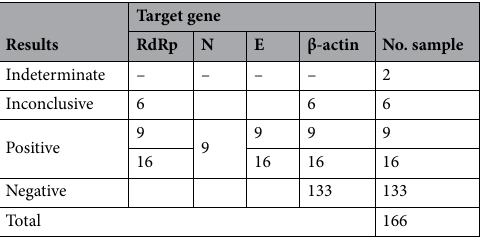
Table 6. Results obtained by our assay (qRT-PCR). S gene was not present in our kit at the time of the initial evaluation here